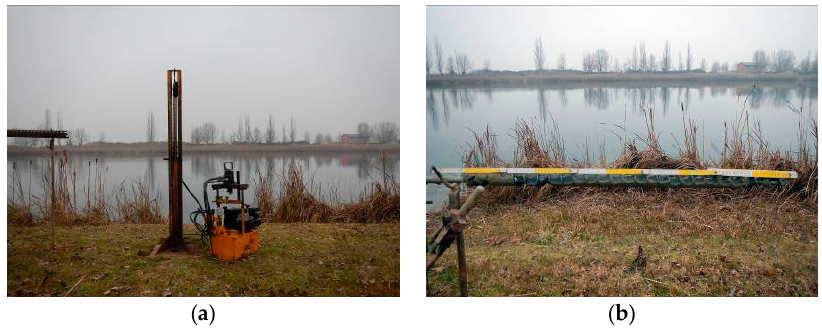
Figure 10. Drilling No. 1 in 2017 in Lago Tramonto, Gambulaga, Portomaggiore (FE, Italy): ( a ) The drilling machine; ( b ) Work in progress while drilling, sediment check (photo by Giovanna Bucci).